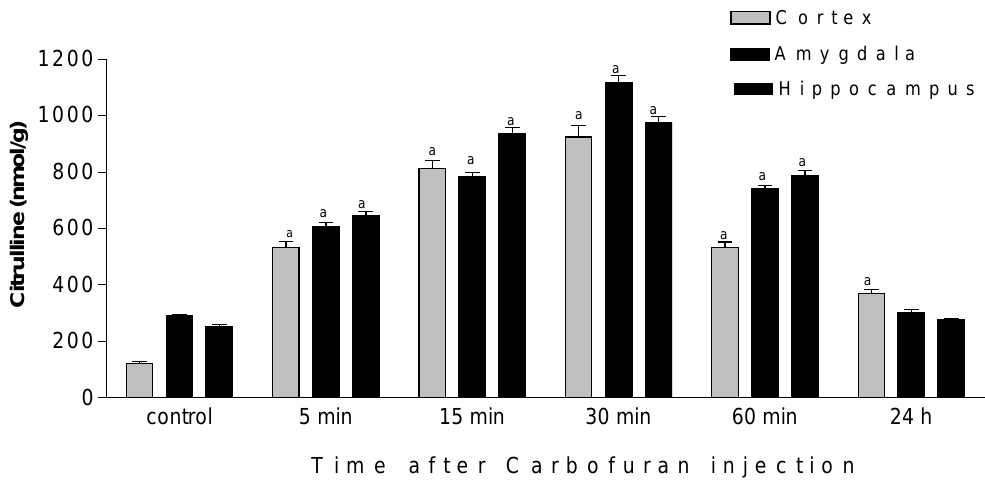
FIGURE 3. Citrulline levels in brain regions of rats intoxicated with an acute dose of CF (1.25 mg/kg, s.c.). Values of citrulline are presented as mean ± SEM (n = 4–6). a Significant difference between control and CF-treated rats ( p <